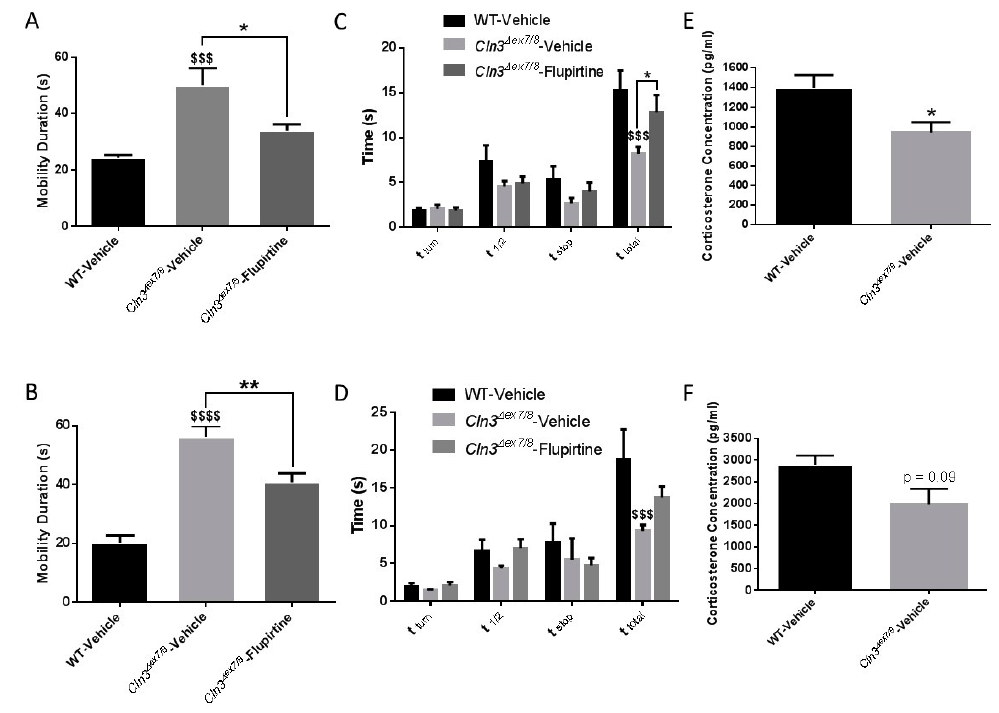
Figure 2. Impact of flupirtine on motor behavior of male and female Cln3 Δ ex7/8 mice. Open field behavioral parameter (mobility duration) in vehicle-treated WT, vehicle-treated Cln3 Δ ex7/8 , and flupirtine-treated Cln3 Δ ex7/8 ( A ) male and ( B ) female mice ( n = 8 per group). Pole climbing test in vehicle-treated WT, vehicle-treated Cln3 Δ ex7/8 , and flupirtine-treated Cln3 Δ ex7/8 ( C ) males and ( D ) female mice ( n = 8 per group). Time to turn (t turn ), time needed to reach center of pole (t 1/2 ), amount of time stopped (t stop ), and total time to descend (t total ) were recorded. All data are expressed as mean ± SEM. $ p : compared to vehicle-treated WT mice; and * p : compared to vehicle-treated Cln3 Δ ex7/8 mice. * p < 0.05, ** p < 0.01, $$$ p < 0.001, and $$$$ p < 0.0001. Corticosterone levels in vehicle-treated WT and Cln3 Δ ex7/8 ( E ) male and ( F ) female mice ( n = 8 per group). Data are expressed as mean ± SEM.